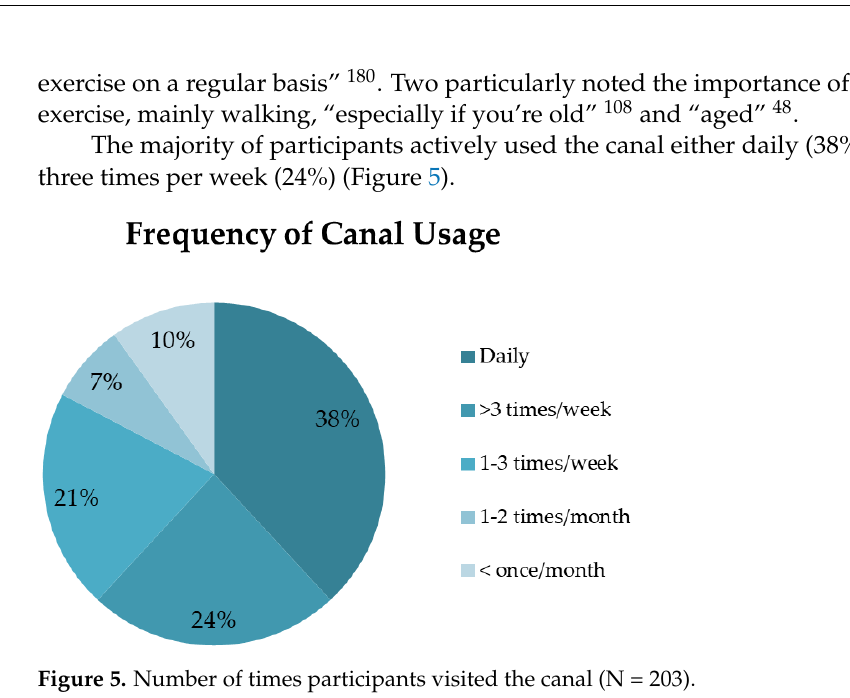
Figure 5. Number of times participants visited the canal (N = 203).